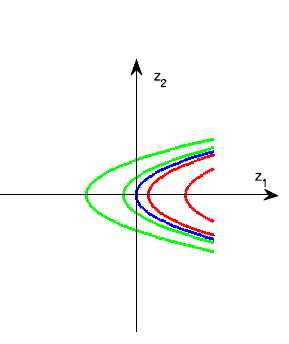
Figure 12. The phase portrait of the first integral H 1 = z 1 − 1